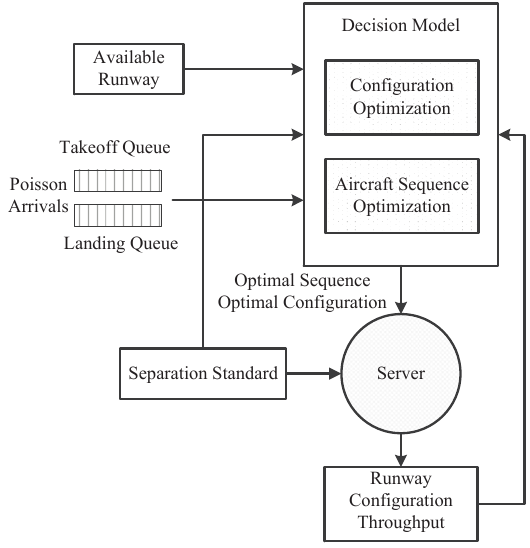
Figure 1. Proposed concept diagram and optimisation